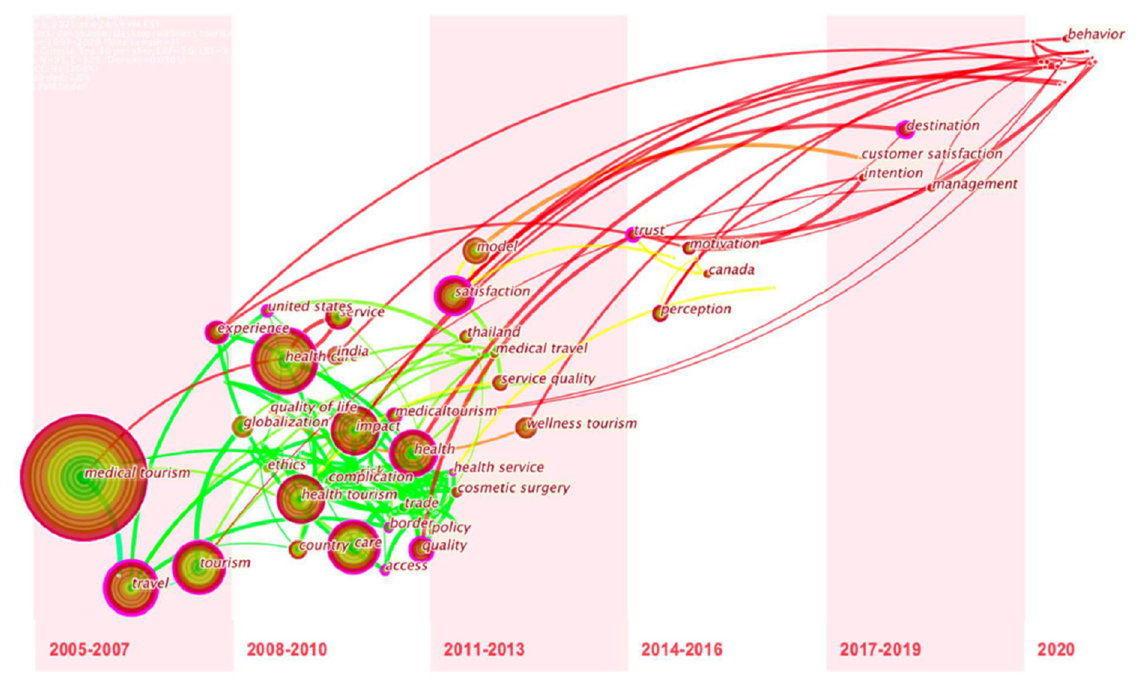
Figure 5. Frequencies of research keywords.